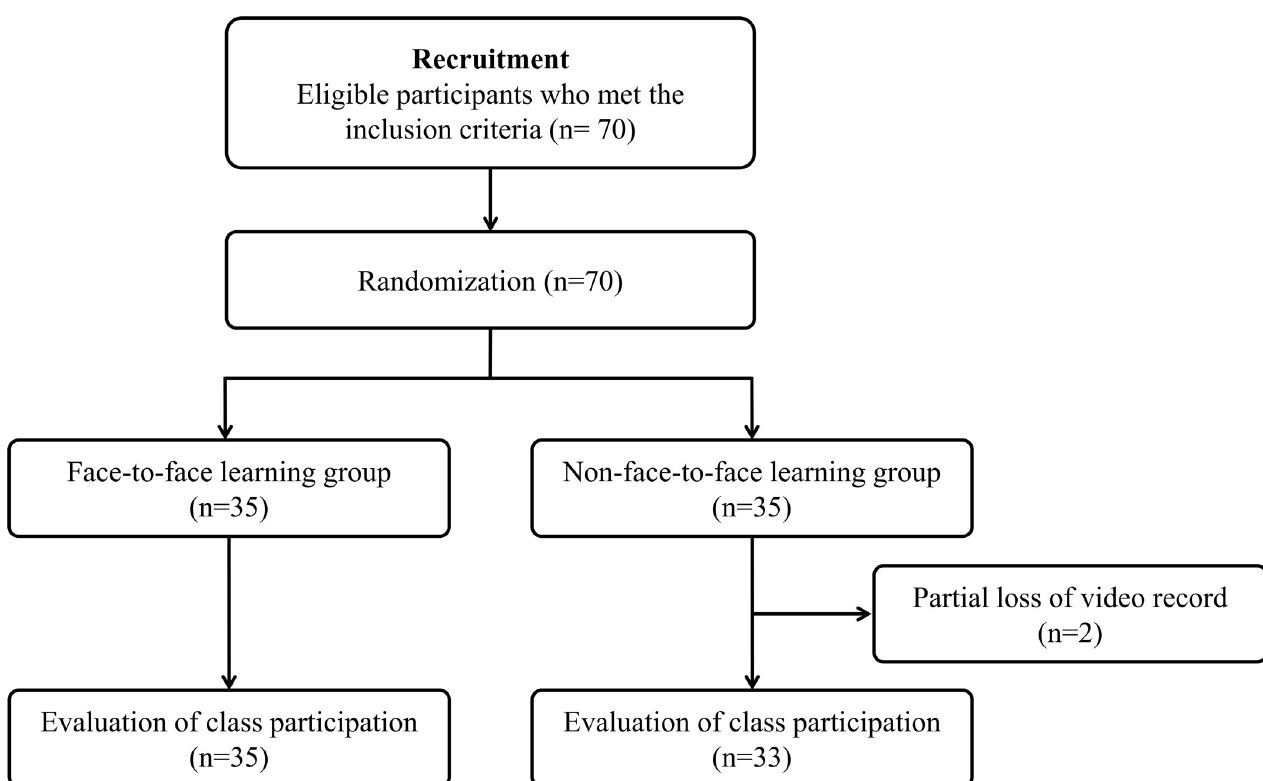
Fig 2. Flowchart for the allocation of participants to the FF and NFF learning groups and video data available for evaluation of class participation and post-training skills. FF, face-to-face; NFF, non-face-to-face.